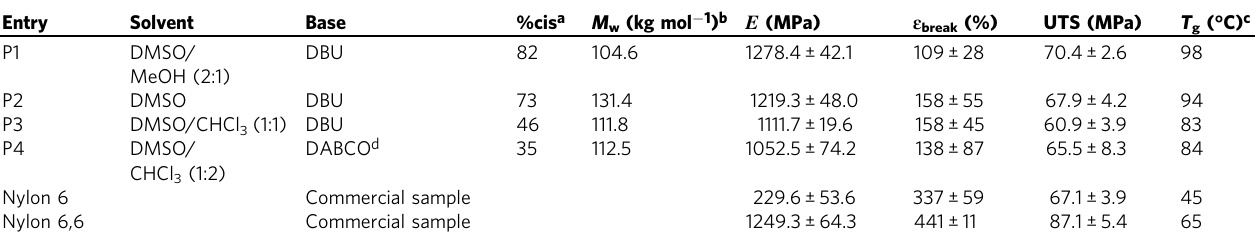
Table 1 Characterisation of material properties for polymers obtained using different polymerisation conditions for C 3 A and C 6 T using 1 mol% base at [C 3 A] = 1